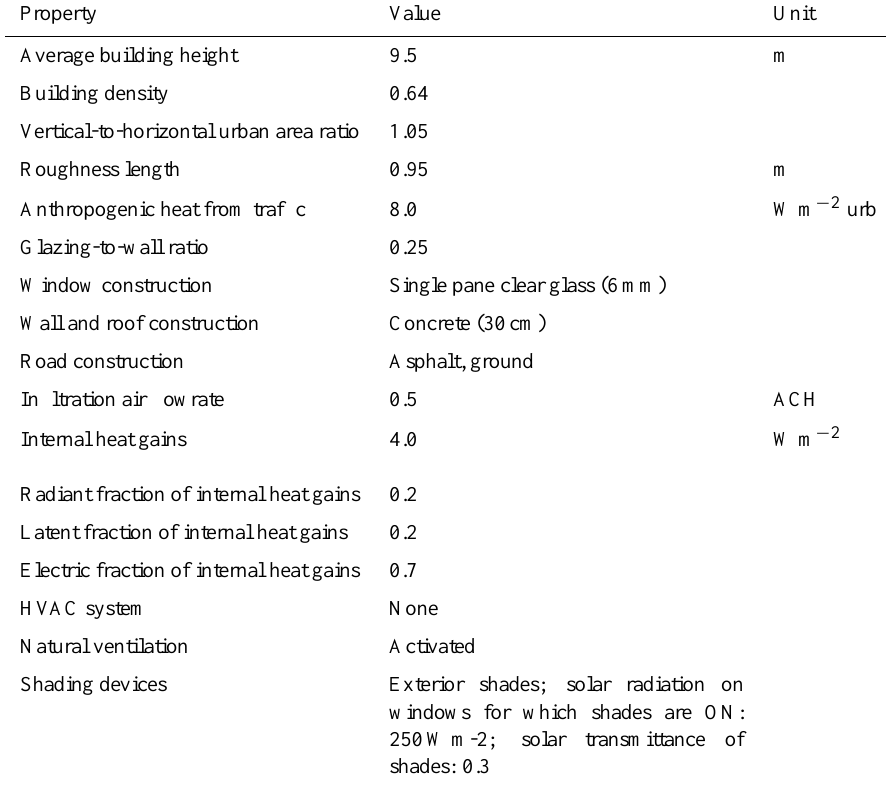
Table 4. Simulation parameters used in the comparison between BEM and observations. This configuration represents an urban area composed of residential buildings in the Egaleo neighbourhood in Athens,